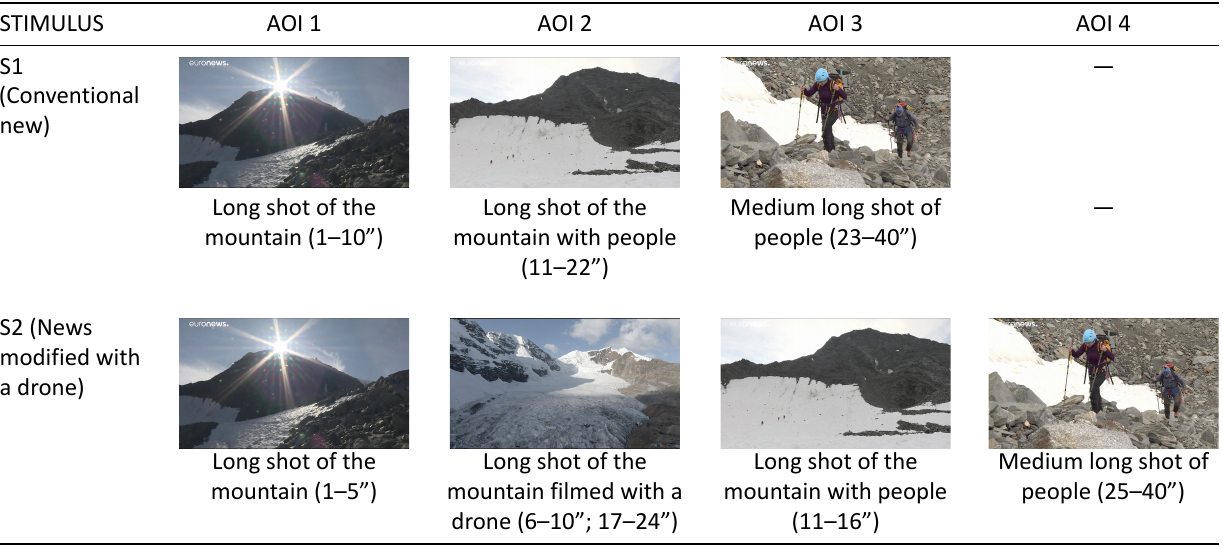
Table 2. Areas of interest (AOI) of the